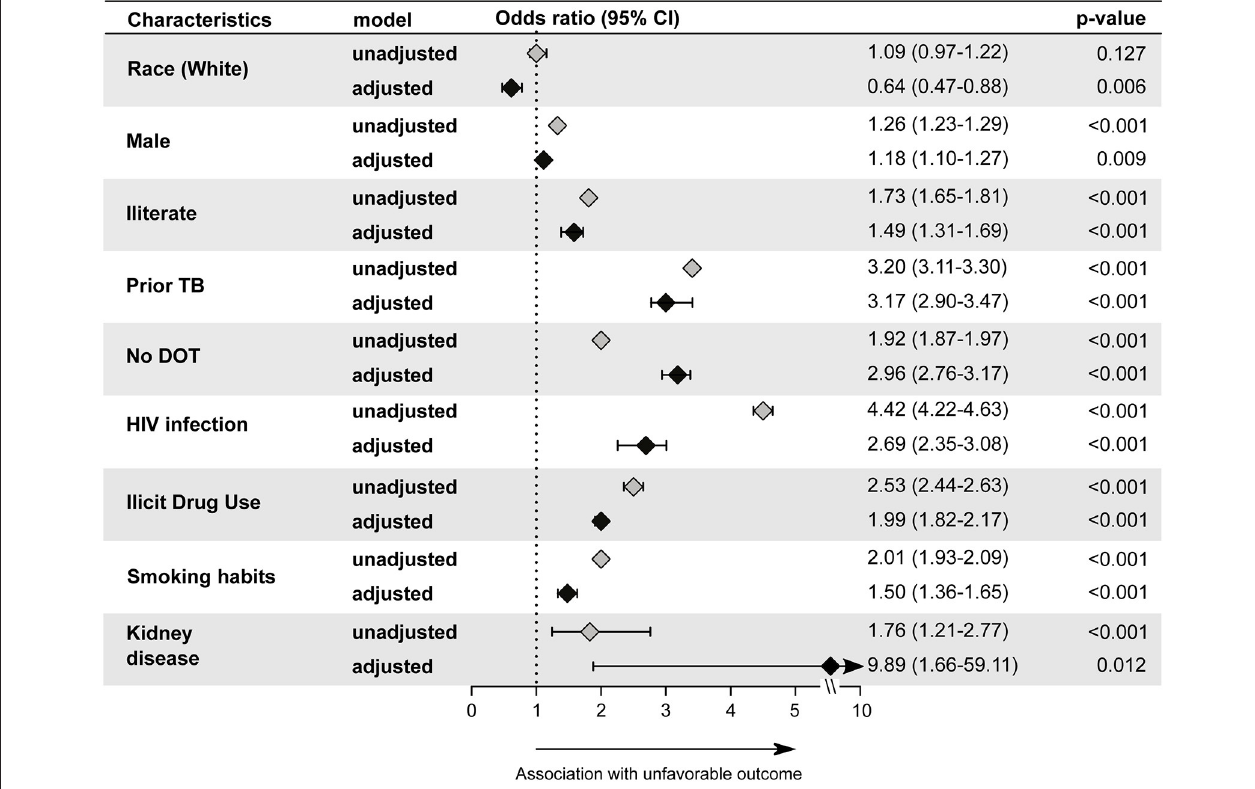
FIGURE 4 | Backward stepwise logistic regression model test independent associations between all the relevant clinical and epidemiological parameters and treatment outcome in young group (10–24 years). The unfavorable outcome was used as reference to test associations. Only parameters which remained with p < 0.05 in in the adjusted model (95%CI: 95% confidence interval) were plotted. Adjustment was performed for each parameter: race (reference: indigenous); male (reference: female); illiterate (reference: literate); prior TB (reference: new case); no DOT (reference: Received DOT). Pulmonary TB (reference: Pulmonary